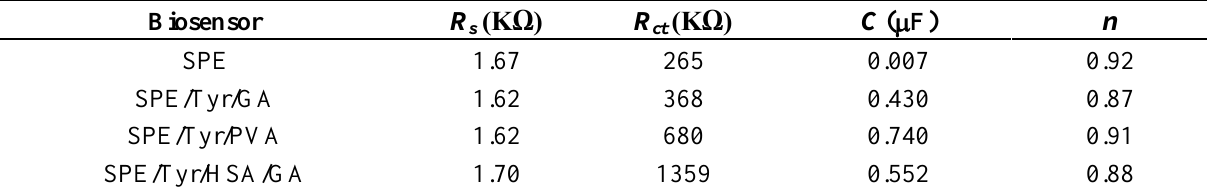
Table 2. Characterization by means of EIS of the bare SPE and the